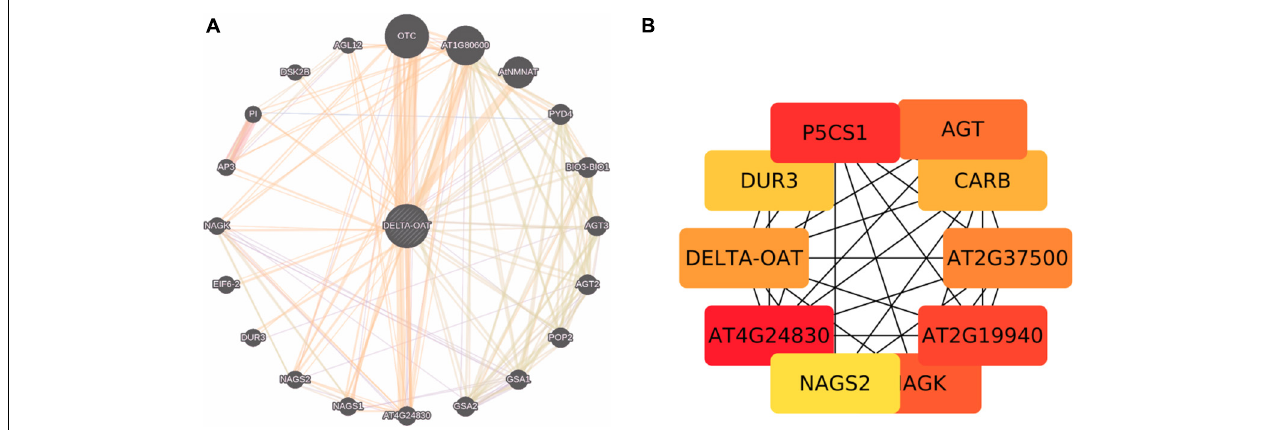
FIGURE 3 | (A) Protein interaction networks generated by genemania.org taking OAT and its interacting partners. (B) Cytohubba prediction of OAT with ranked genes. Brighter the node, larger is the adherence of accumulated stress